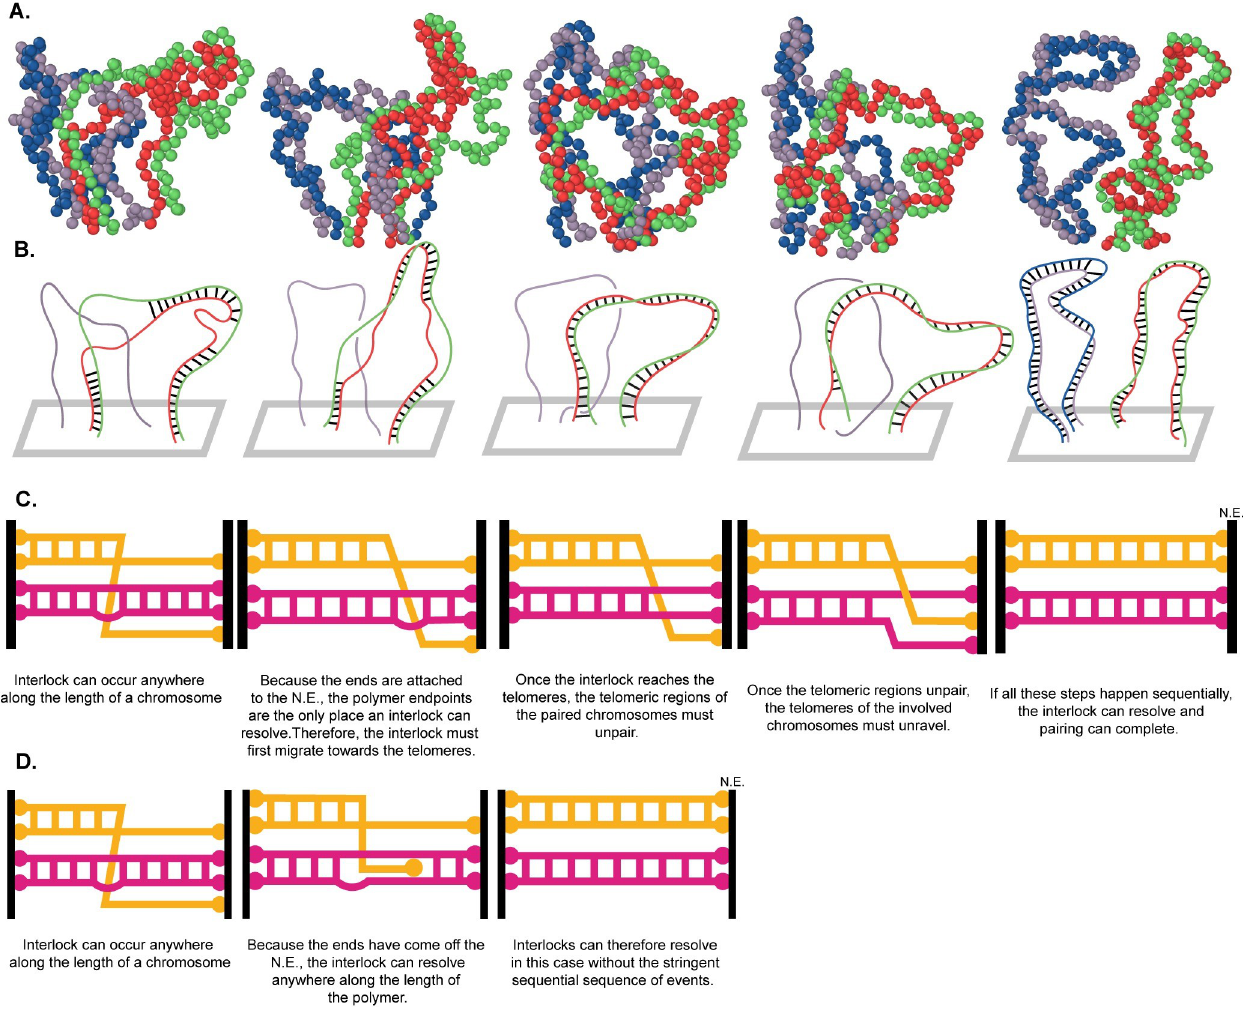
Fig 9. Geometry of interlock resolution. A) Simulation results showing interlock migration to telomeres followed by complete resolution. (B) Simplified drawing of the same interlock resolution event showing gradual migration of the interlock to the end, after which telomere re-arrangement leads to the blue chromosome becoming disentangled from the red/green paired chromosome. (C) Cartoons of steps required for interlock resolution with both ends are attached to the NE (D) Cartoon representation of steps required for interlock resolution if at least one end of the chromosomes is unattached.